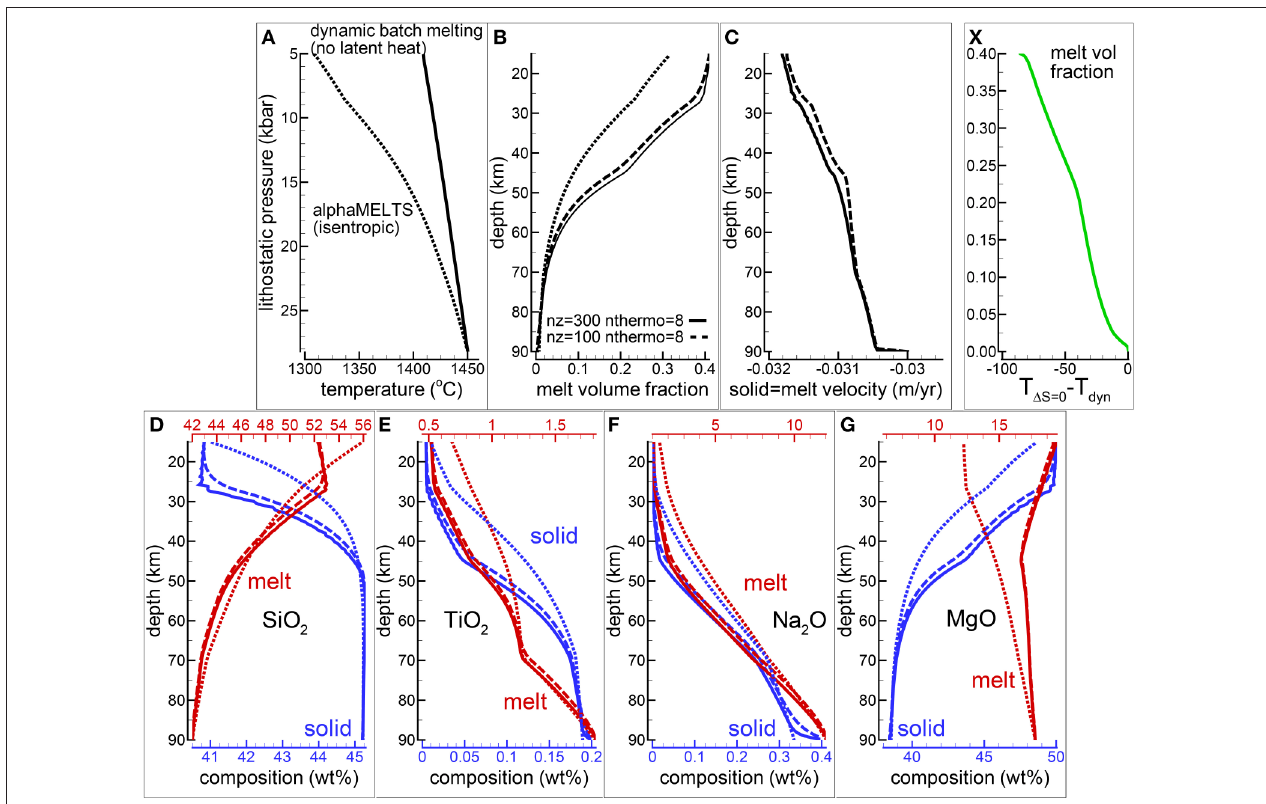
FIGURE 3 | Dynamic batch melting, υ melt = υ solid . Latent heat of melting is not included in the model. (A) Temperature vs. lithostatic pressure, (B) variation of the melt volume fraction over depth, (C) solid and melt velocity, (D–G) composition of the solid and melt (wt %) (D) SiO 2 , (E) TiO 2 , (F) Na 2 O , (G) MgO . The dotted lines show the results for an isentropic melting model using AlphaMELTS. Solid and dashed lines illustrate the results of dynamic batch melting model using different number of grid points nz = 300, 100. The number of time steps between two thermodynamic calculations (nthermo) is 8. Using nz = 100, nthermo = 8 or nz = 200, nthermo = 16 the results are very similar and they are not included in the plot. (X) Quantifies the temperature difference between the dynamic batch melting and the isentropic model as a function of the melt volume fraction obtained using the dynamic batch melting model. A movie of a dynamic batch melting simulation is available following the link provided in the Supplementary Material (movie file mf1-movie2.PHASE3-P.BRC4-5.avi